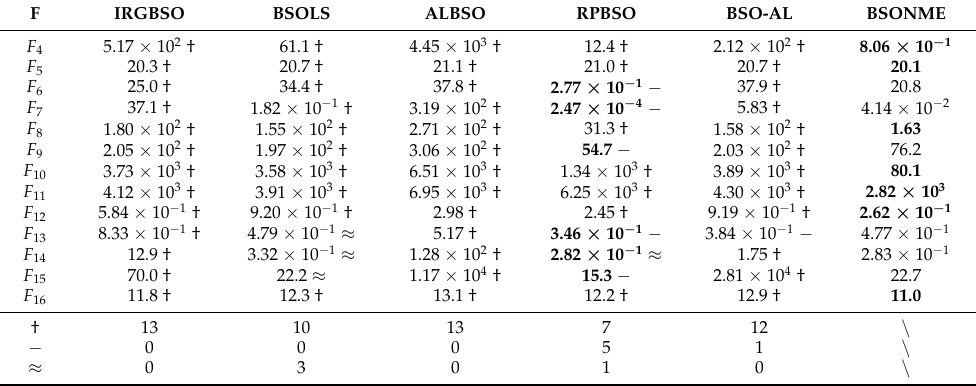
Table 8. Experimental results of IRGBSO, BSOLS, ALBSO, RPBSO, BSO-AL, and BSONME on F 4 – F 16 .